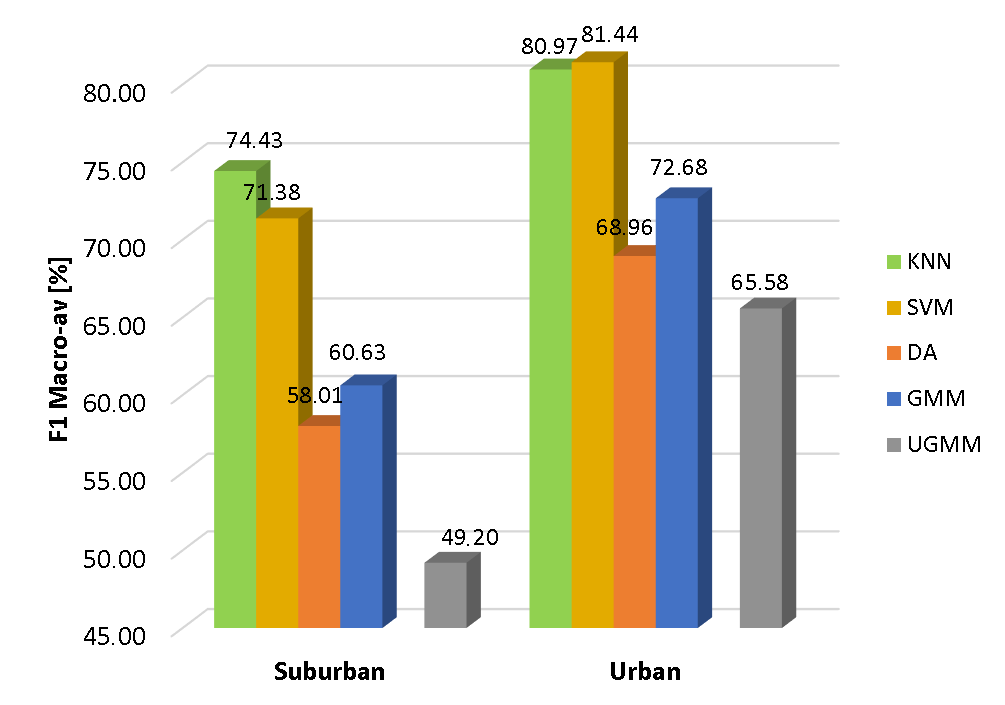
Figure 2. Classification performance of the studied classifiers for the suburban and urban